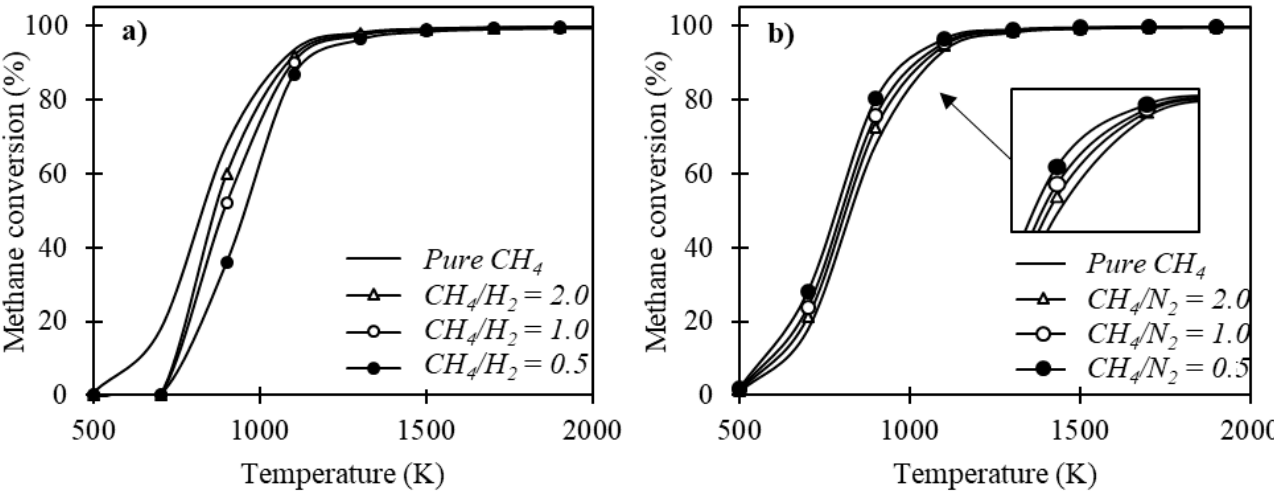
Figure 7. Effect of hydrogen ( a ) and nitrogen ( b ) addition on the methane cracking process at 1 atm.